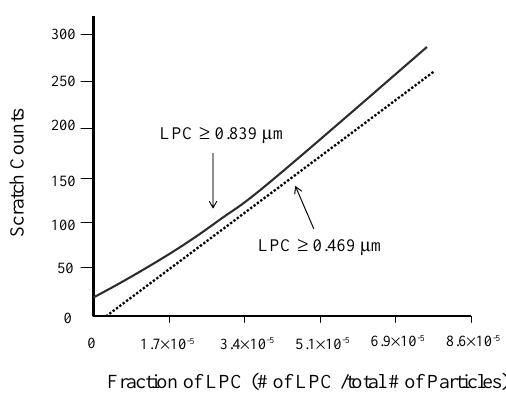
Fig.8 Correlation between wafer scratch counts and LPC for particles with diameters ranging from 0.469 to 1.887 µ m ( Fig.9 in [46)]; Re- drawn with permission from The Electrochemical